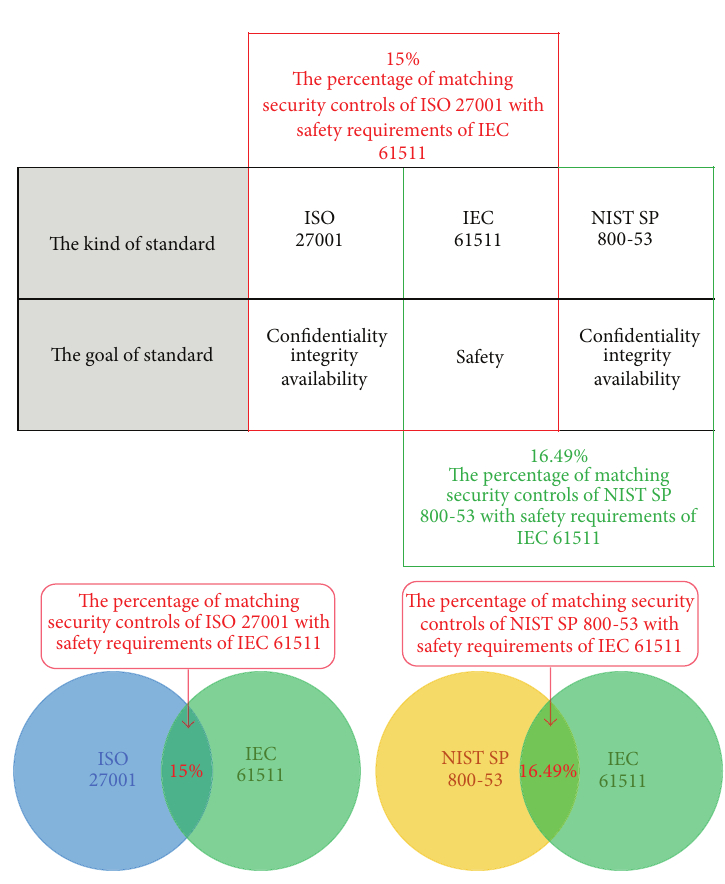
Figure 9: Comparative analysis for controls of international